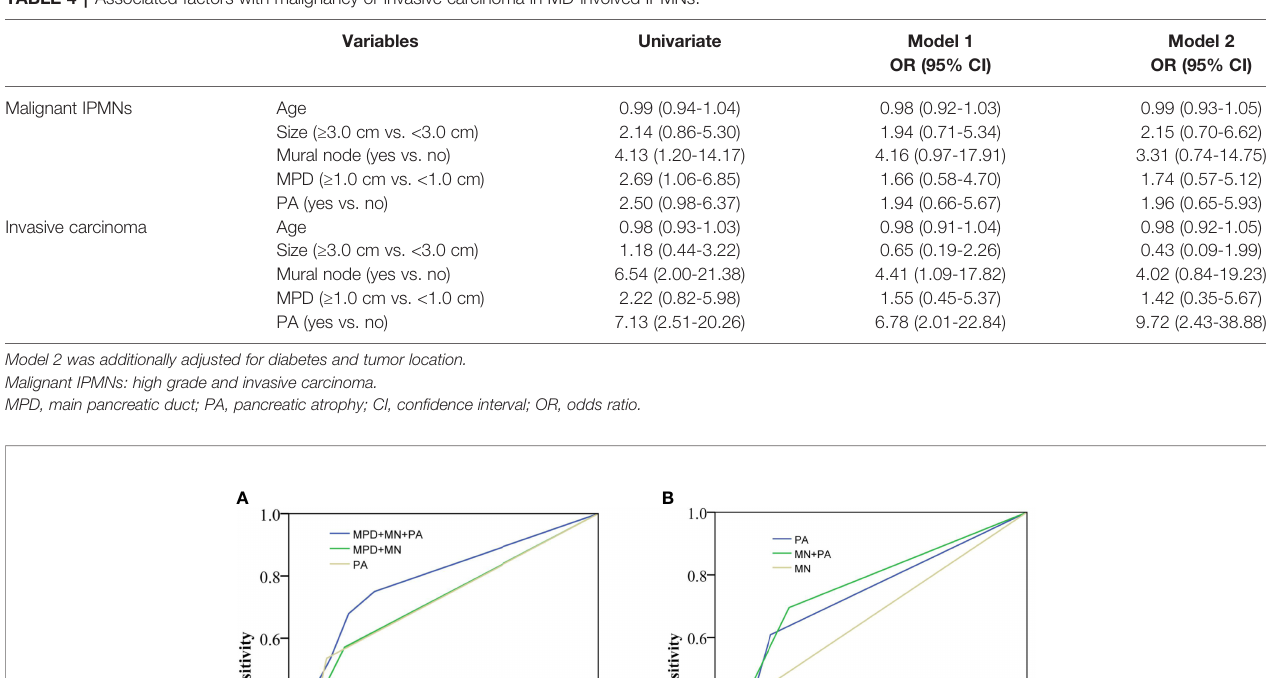
TABLE 4 | Associated factors with malignancy or invasive carcinoma in MD-involved IPMNs.